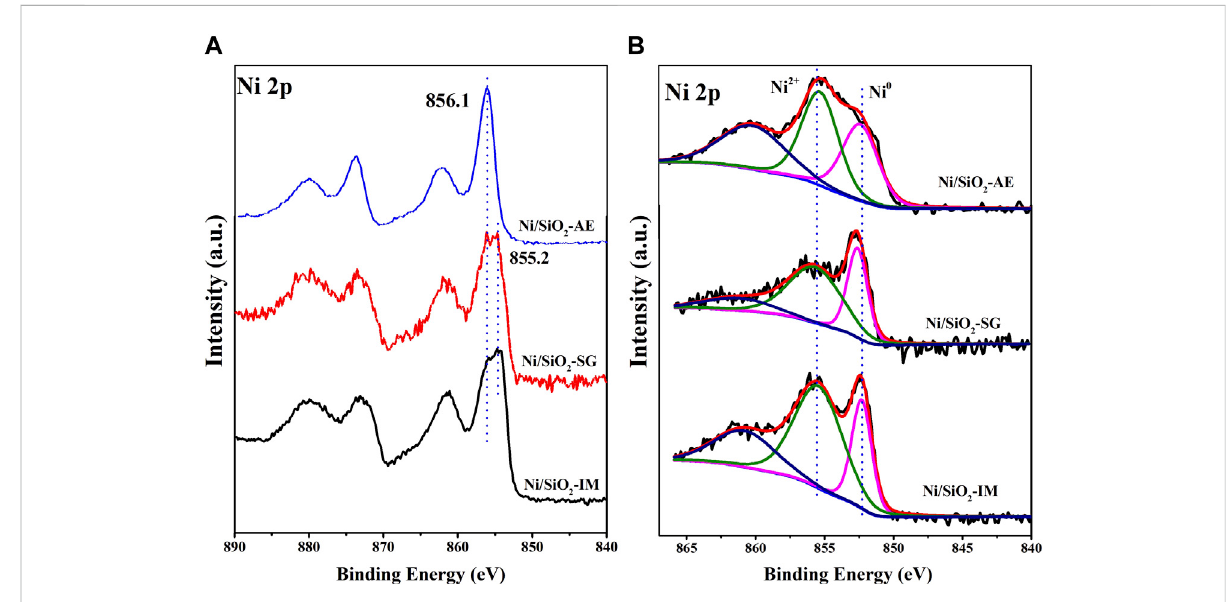
FIGURE 6 The XPS spectra of Ni-based catalysts: Calcined samples (A) and reduced samples (B)